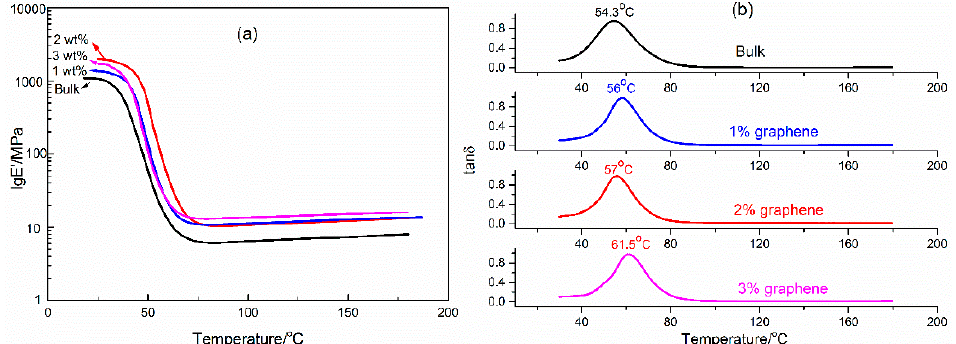
Figure 5. DMA curves of the graphene/H-EP composites: ( a ) storage modulus (lg E ’) of graphene/H-EP composites; and ( b ) tan δ curves of graphene/H-EP composites.